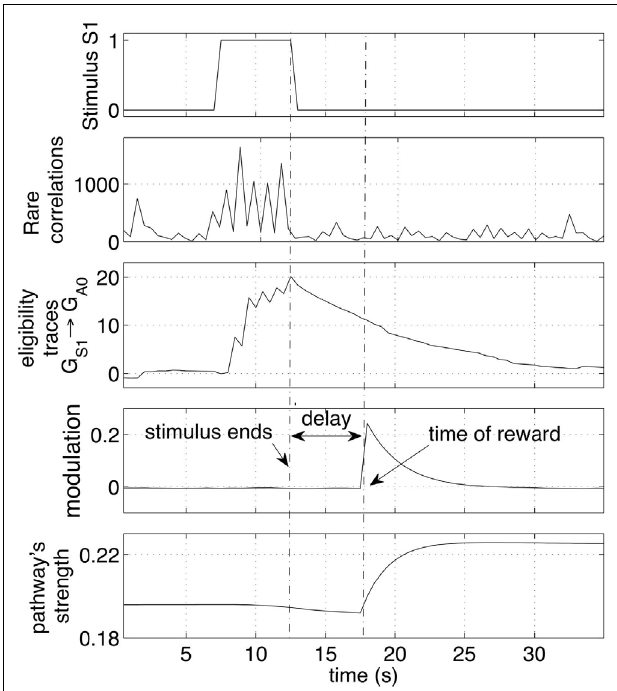
FIGURE 7 | Effect of a stimulus followed by a reward. The sequence of stimulus, rare correlations, eligibility traces, reward and weight increase is shown during a 30s interval.The network preserve a memory of a recent stimulus by selectively creating eligibility traces along the pathways that transmit signals.The traces are later converted to weight increase if a reward is delivered.The strength of the pathway is represented as the average